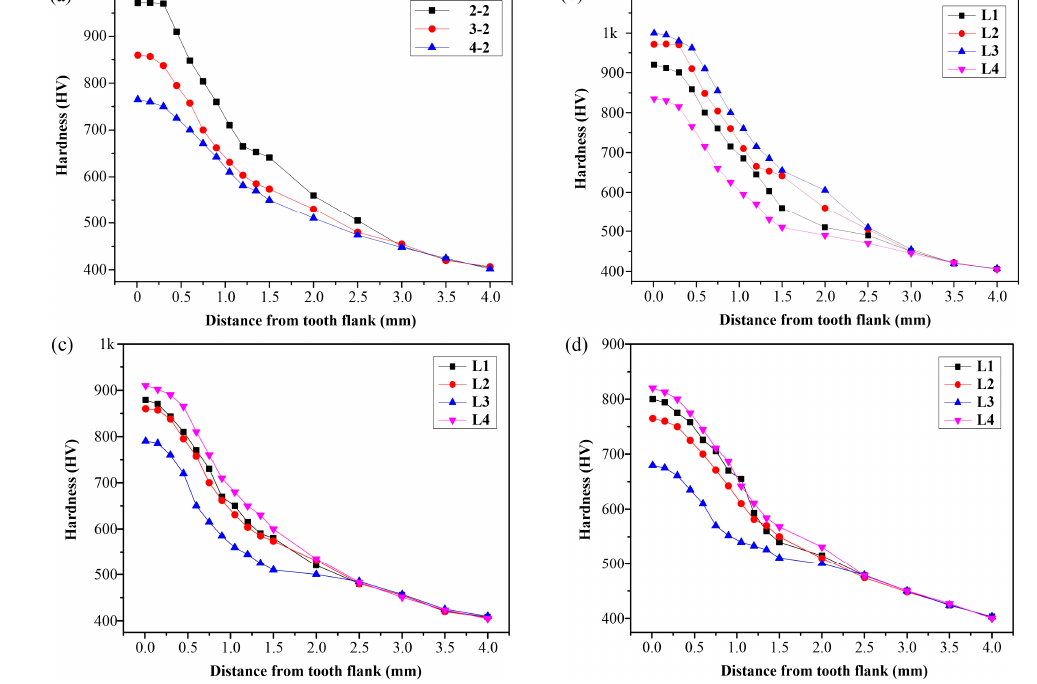
Figure 16. Hardness distributions measured for gear teeth: ( a ) gear 2-2, 3-2, and 4-2; ( b ) L1, 2, 3, and 4 of gear 2-2; ( c ) L1, 2, 3, and 4 of gear 3-2; and ( d ) L1, 2, 3, and 4 of gear 4-2. Metals 2018 , 8 , x FOR PEER REVIEW